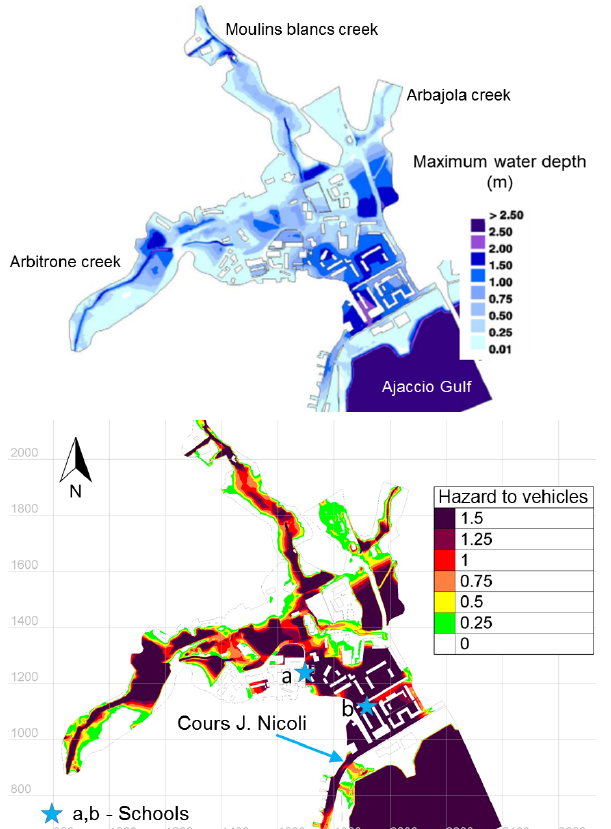
Figure 2. Flood depth map for the simulated 100 years scenario (top) and temporal maximum of the hazard for vehicles with identi- fication of vulnerable buildings and main traffic artery